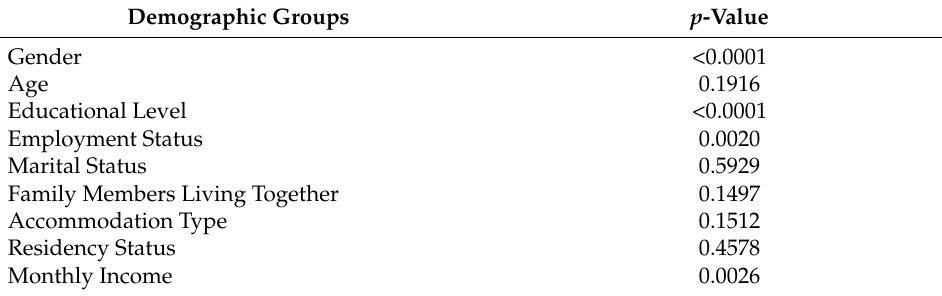
Table 9. Comparative Analysis.